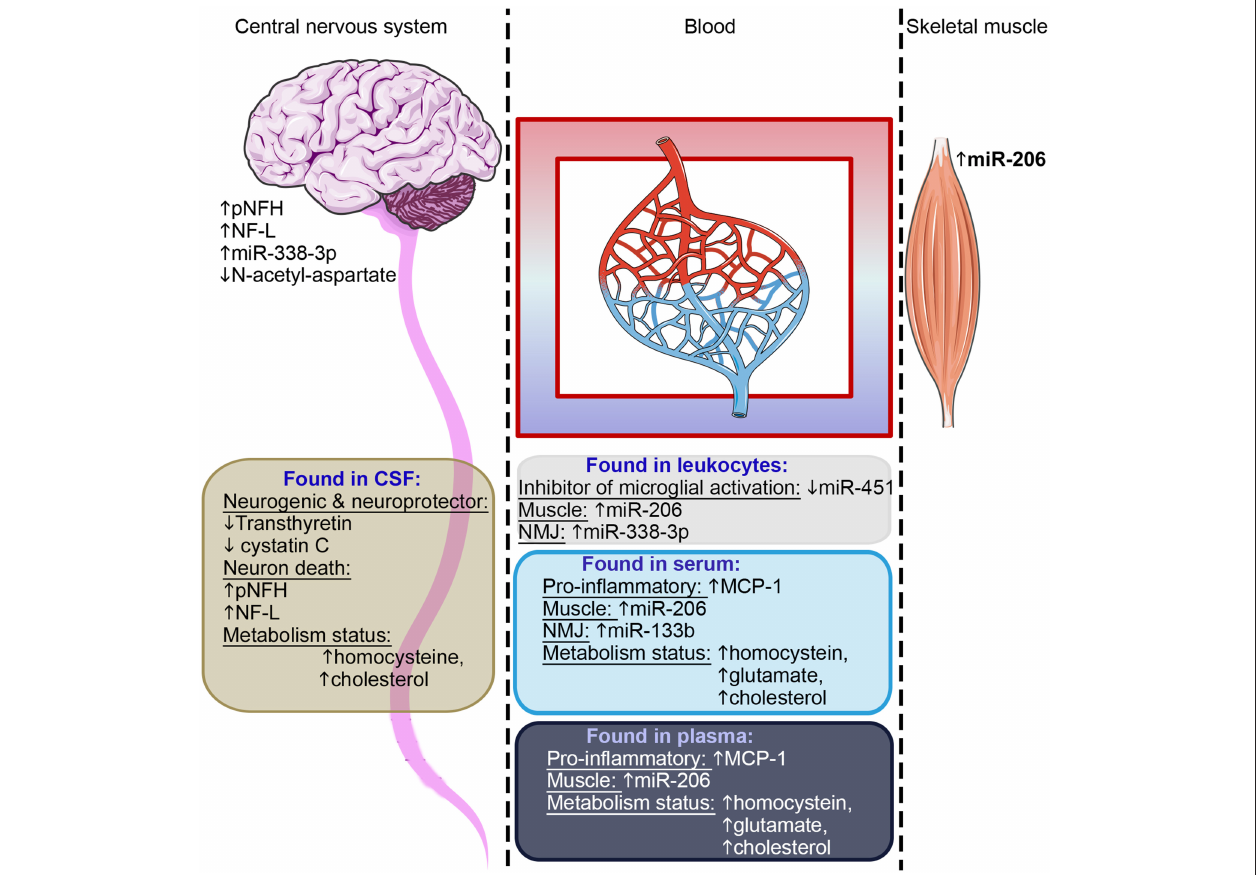
FIGURE 3 | Summary of candidate biomarkers consistently found across studies. Candidates observed in CSF are highlighted in brown, in leukocytes in gray, in serum light blue and in plasma dark blue. These candidate biomarkers reflect the motor neuron health, the inflammatory status, skeletal muscle health, and metabolism status–as indicated in each text block. Some of these candidates were found in postmortem central nervous tissue or on muscle biopsies. NMJ, neuromuscular